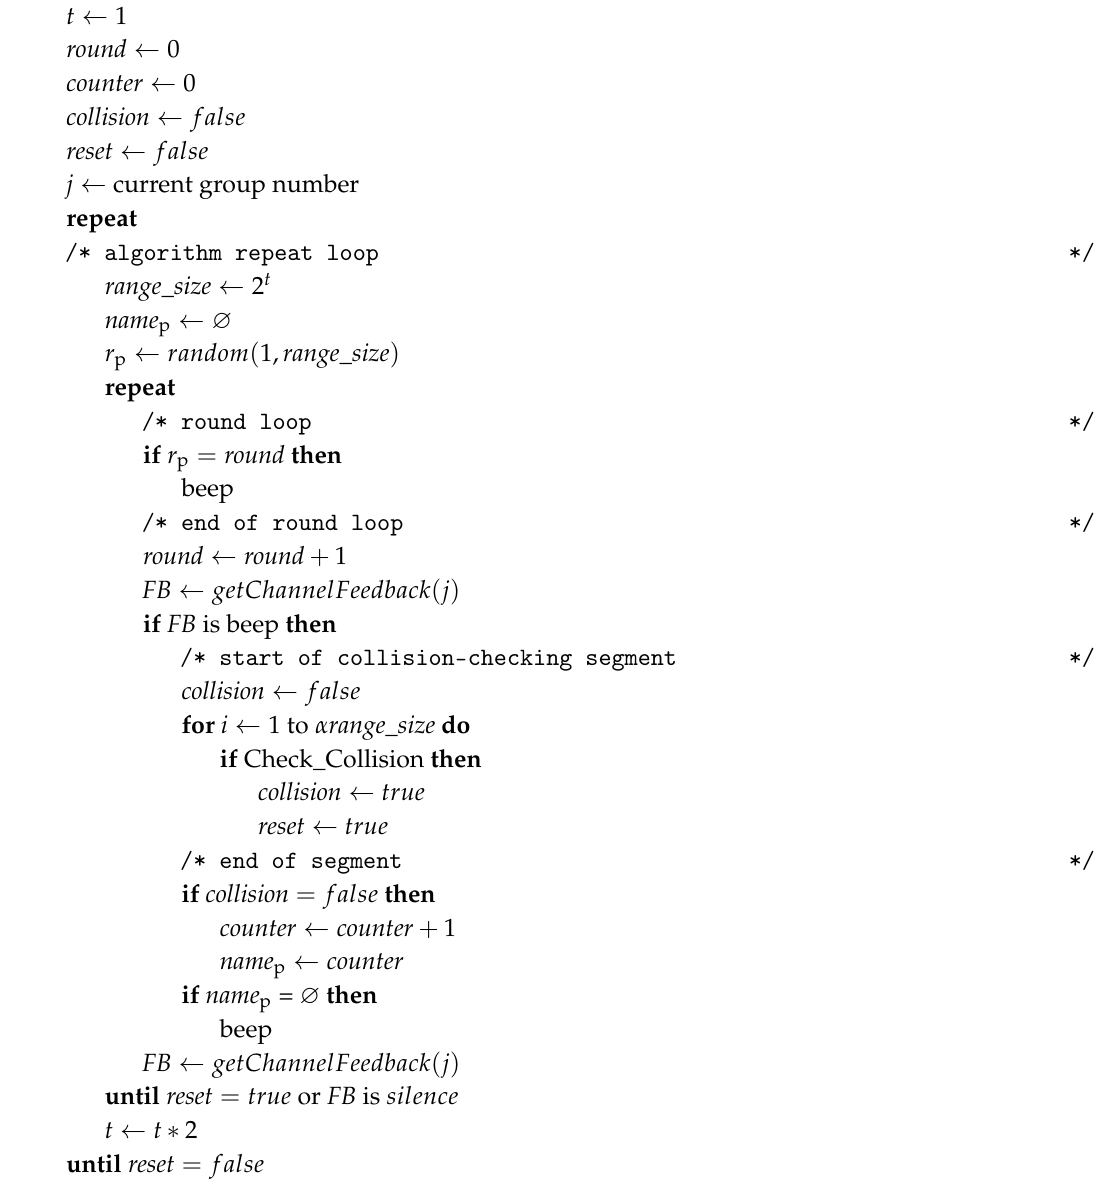
Algorithm 5: U NKNOWN S INGLE G ROUP B EEP N